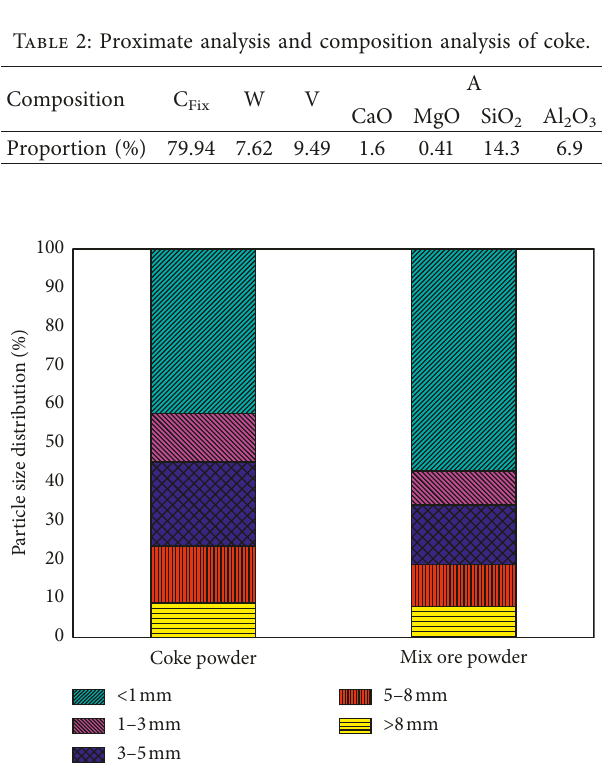
Figure 1: The full size distribution of the coke powder and mix ore powder. Table 3: Proportion scheme of sintering raw materials (mass fraction,